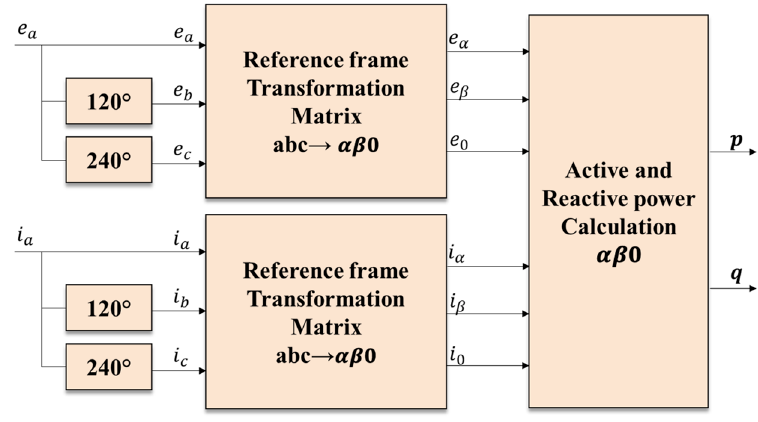
Figure 7. Power calculation by αβ 0 method.